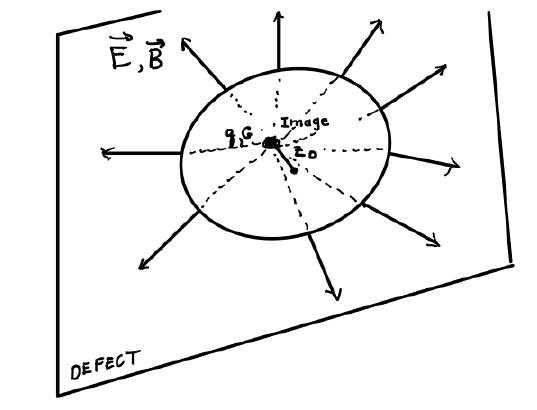
Figure 1 . Lines of electric and magnetic (cid:13)ux apparently emanating from the image electric and magnetic monopole which always appears on the side of the defect that is opposite to the